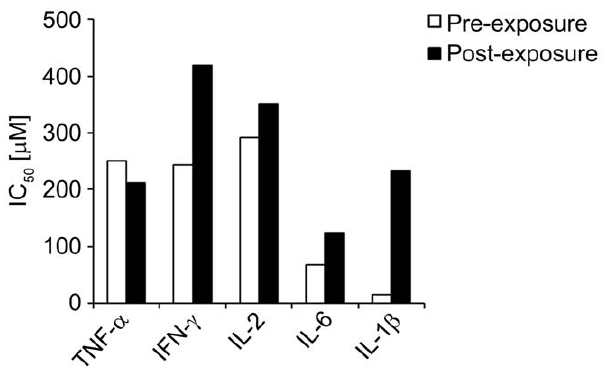
Figure 7. Pre or post exposure treatment of EM-163 inhibits TNF- a , IFN- c , IL-2 and IL-1 b production. Human MNCs (5 6 10 5 /well) were treated with EM-163 for 30 min before (pre-exposure) or 30 min after (post-exposure) being exposed to SEB(200 ng/ml) and varying concentrations of EM-163 (1 mM, 500 m M, 100 m M and 10 m M). Culture supernatants were collected after 16 h and analyzed for cytokine release using a MSD assay. The IC 50 value was calculated as the concentration required for inhibition of cytokine production by 50% relative to the control. Data represent five experiments.